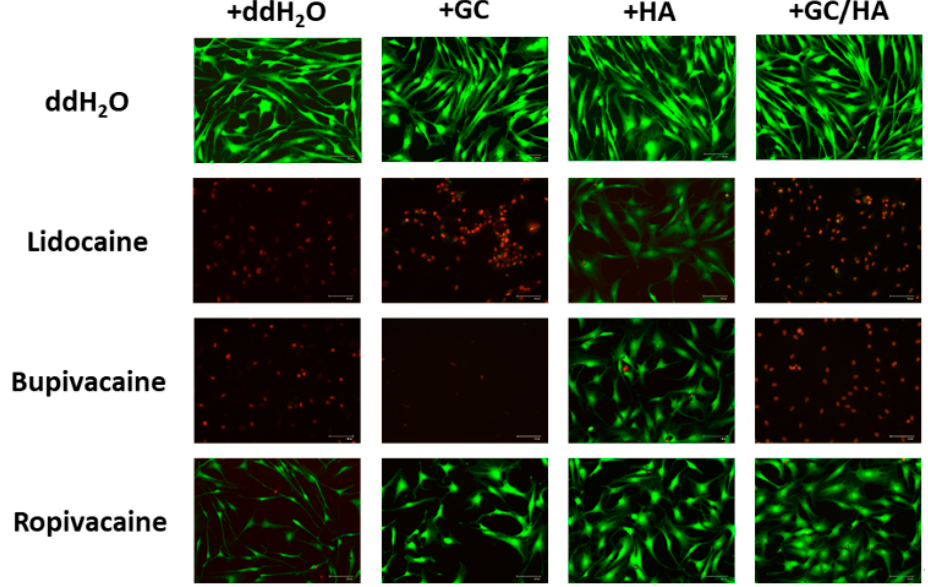
Figure 6. Live/Dead assay shows viable cells in test conditions for local anesthetics plus HA. In other test conditions, lidocaine and bupivacaine led to cell death, while ropivacaine showed viable cells in all test